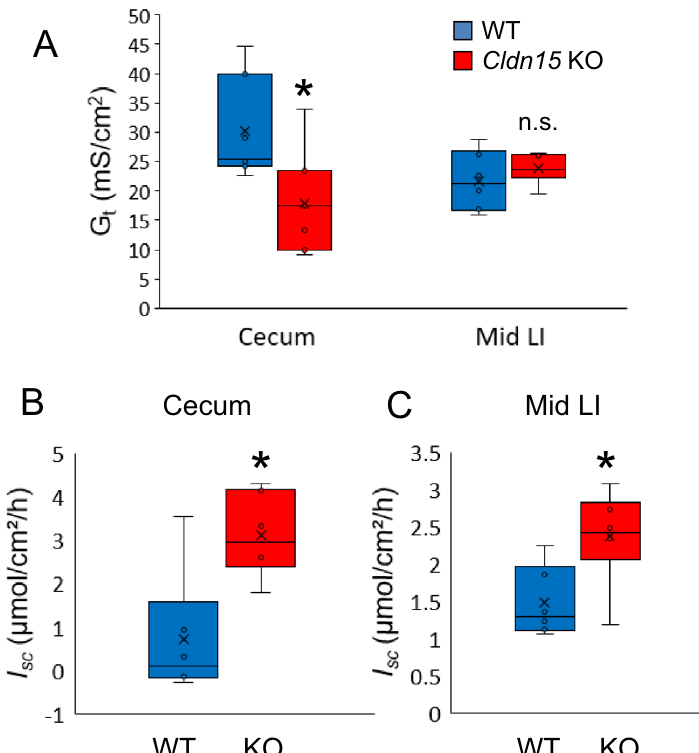
Figure 5. Baseline electrical parameters in the cecum and middle large intestine. ( A ) The baseline transmembrane electrical conductance ( G t ) of the cecum and middle large intestine was measured under short- circuit conditions in Ussing chambers (n = 6 (including 1 female) and 7, KO and WT, respectively). The baseline short-circuit current ( I sc ) was measured in the ( B ) cecum and ( C ) the middle large intestine. The box plots represent the minimum, first quartile, median, third quartile, and maximum values, the mean is marked with an X, n = 5 (including 1 female) and 6 for KO and WT, respectively for figures ( B ) and ( C ). Statistical significance from left to right: ( A ) *P = 0.017; n.s. P = 0.485; ( B ) *P = 0.026; ( C ) *P = 0.026, Mann–Whitney U test, Cldn15 KO vs. WT. Please see supplementary table 2 for data